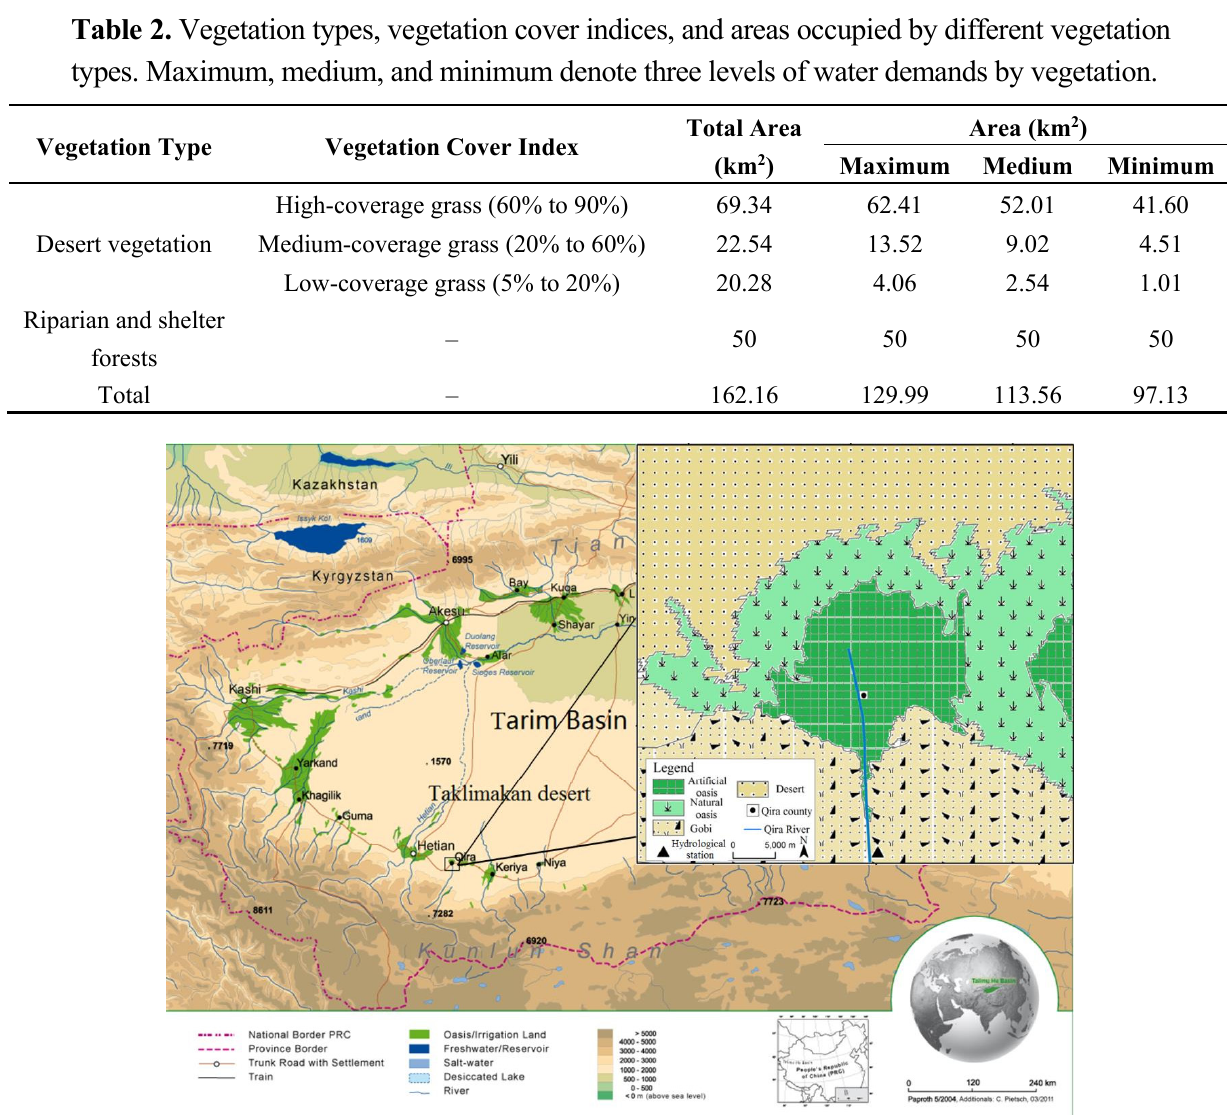
Figure 2. Location and topography of the study area, adapted from the project SuMaRiO